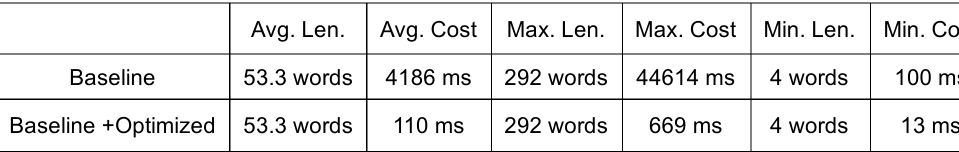
Table 9 Performance vs. Optimized baseline